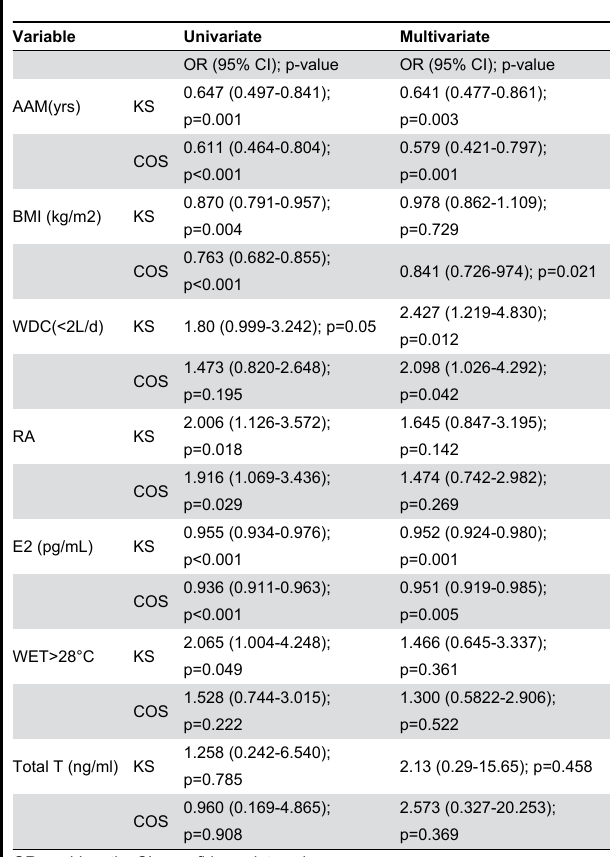
Determinants of kidney stones (KS) and calcium oxalate stones (COS) for all 197 subjects, respectively.